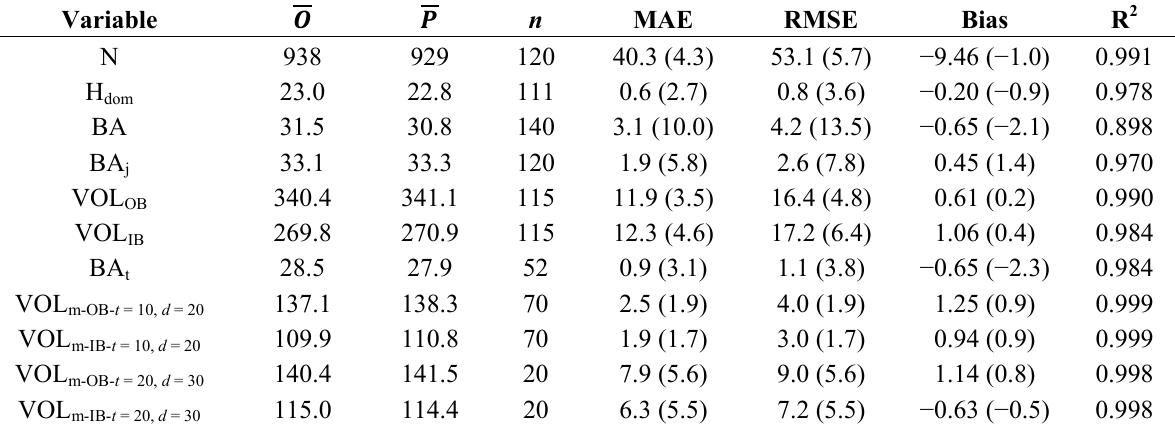
Table 4. Summary of model evaluation statistics for N, H estimations based on 30